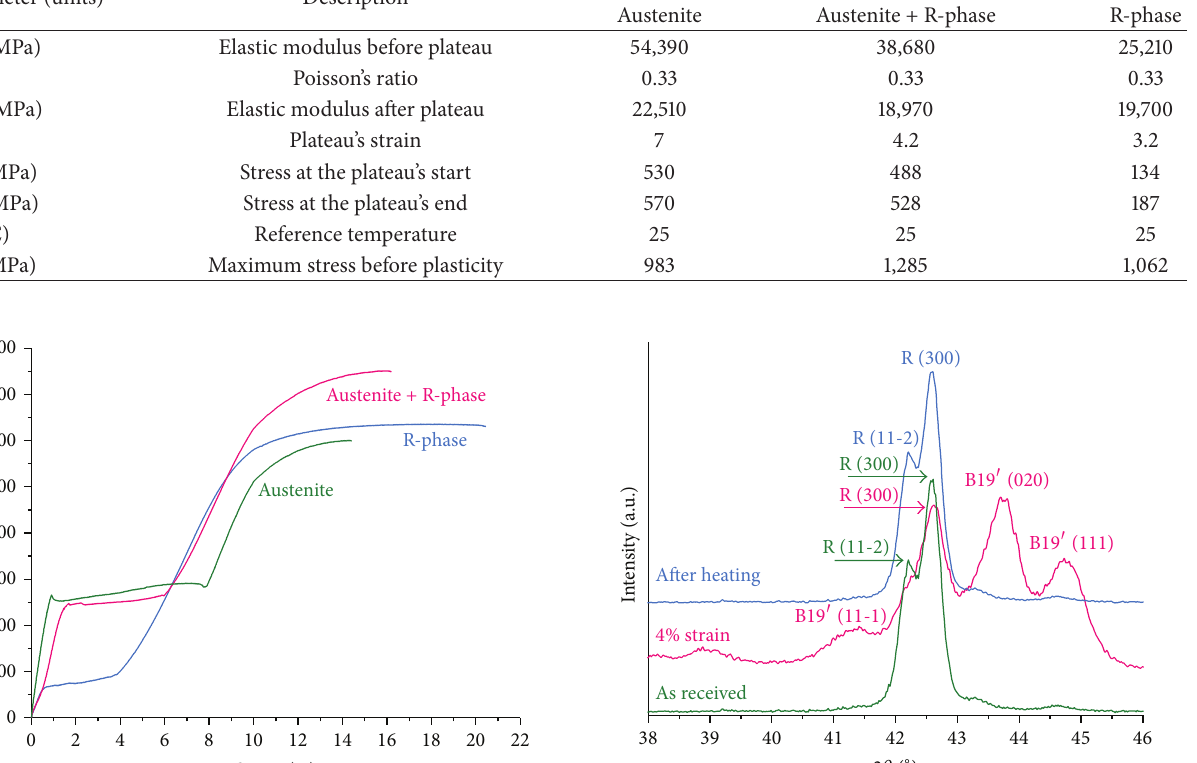
Table 2: Parameters obtained through tensile tests and used to describe the constitutive models for simulation. Parameter (units)